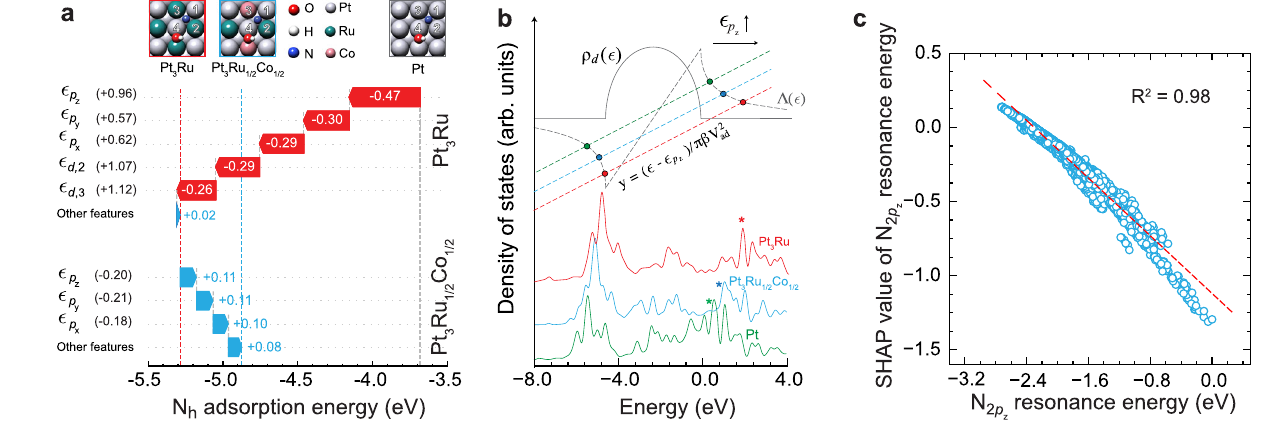
Fig. 5 | Physicochemical insights from interpretable deep learning. a Local interpretation of N h adsorption on Pt 3 Ru(100) relative to Pt(100) and Pt 3 Ru 1/2 Co 1/2 (100) to Pt 3 Ru(100). b A graphical illustration of the Newns- Anderson model for an adsorbate resonance state interacting with metal d -states. DFT-calculated DOS projected onto the 2 p z orbital of *N h on